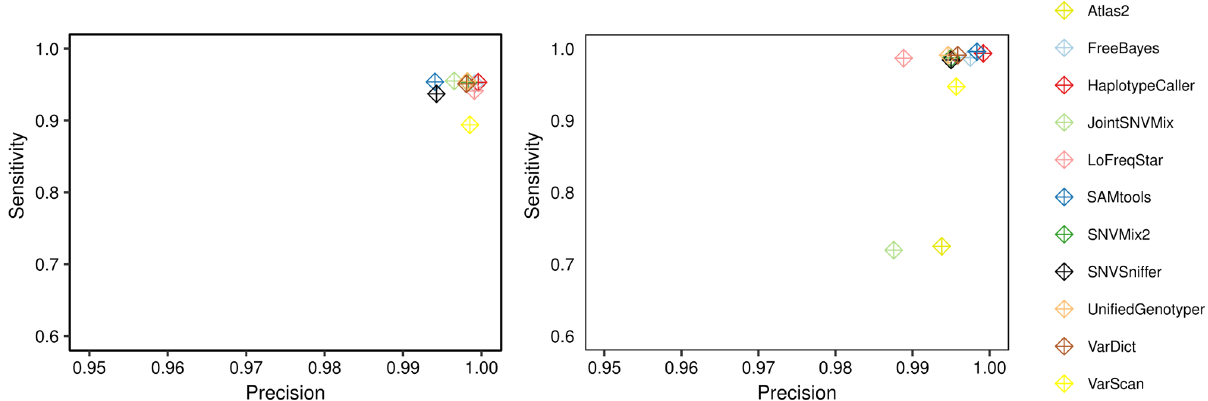
Fig 3. Benchmarking results for germline SNVs. Sensitivity versus precisionis shown for A. exome and B. targeted gene panel data.